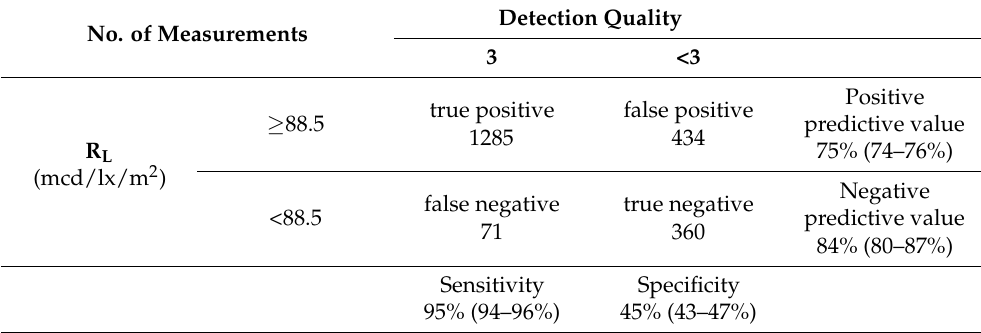
Table 7. Diagnostic value of determined R L cut-off point of 88.5 mcd/lx/m 2 for level 3 detection